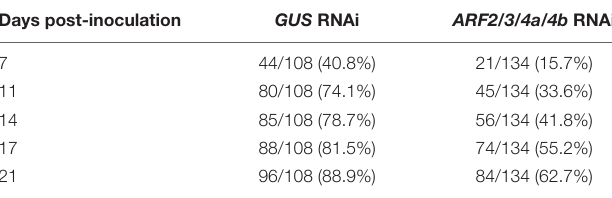
TABLE 1 | Number and percentage of plants with